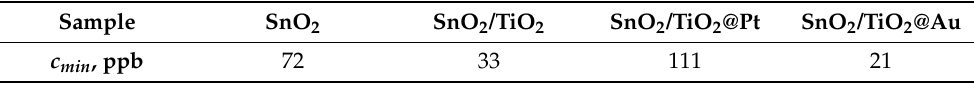
Table 2. Minimum detectable HCHO concentration c min measured at 200 ◦ C for sensors based on investigated